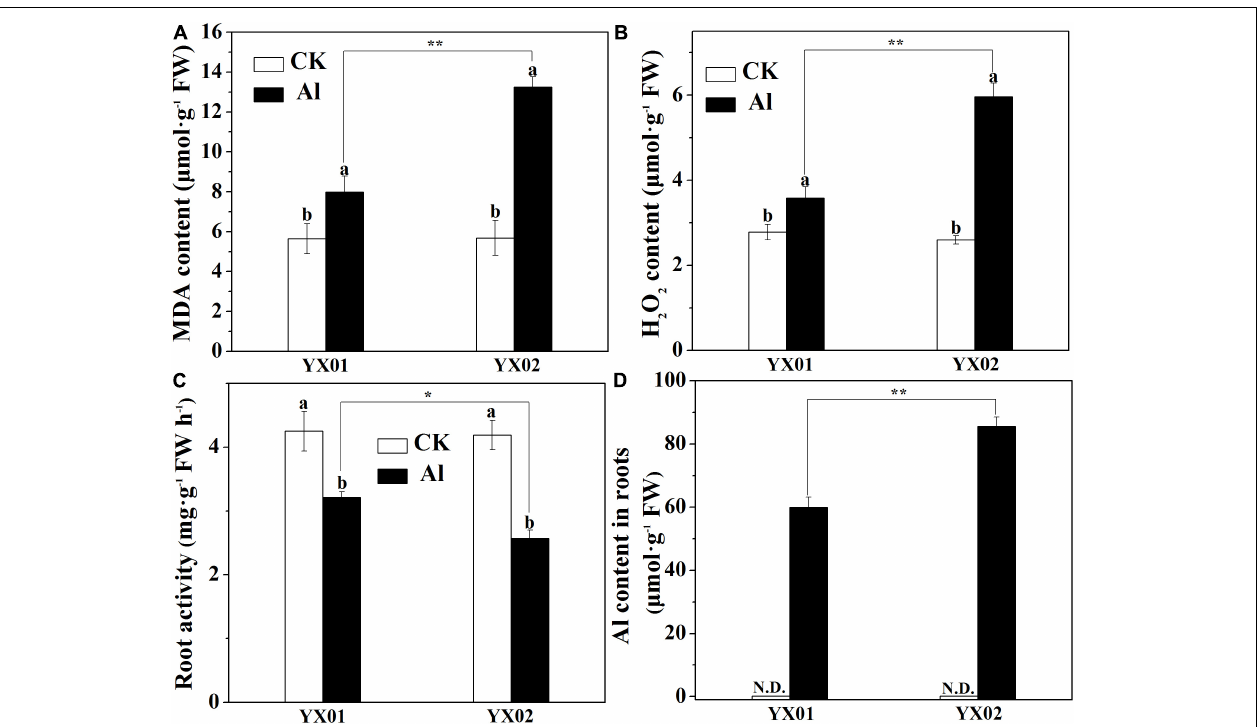
FIGURE 2 | Effects of Al treatment on malondialdehyde (MDA) content (A) , hydrogen peroxide content (B) , root activity (C) and Al content (D) in roots of Chinese fir seedlings. Two-month-old Chinese fir seedlings were exposed to 1/2 strength complete nutrition solution without Al (CK), or with 1 mM AlCl 3 (Al) for 16 d. After treatment, root tips of Chinese fir were collected for analysis. Bars are means of four replicates ± SD. Different letters above histogram represent significant differences at P < 0.05 . * or ** above lines represent significant differences between genotypes at P < 0.05 and P < 0.0 1, respectively. N.D. indicates not